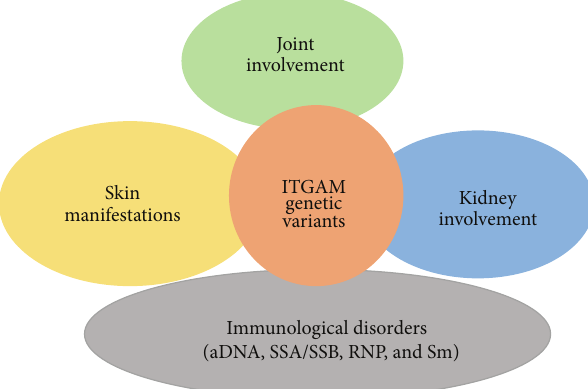
Figure 2: Disease manifestations associated with ITGAM genetic